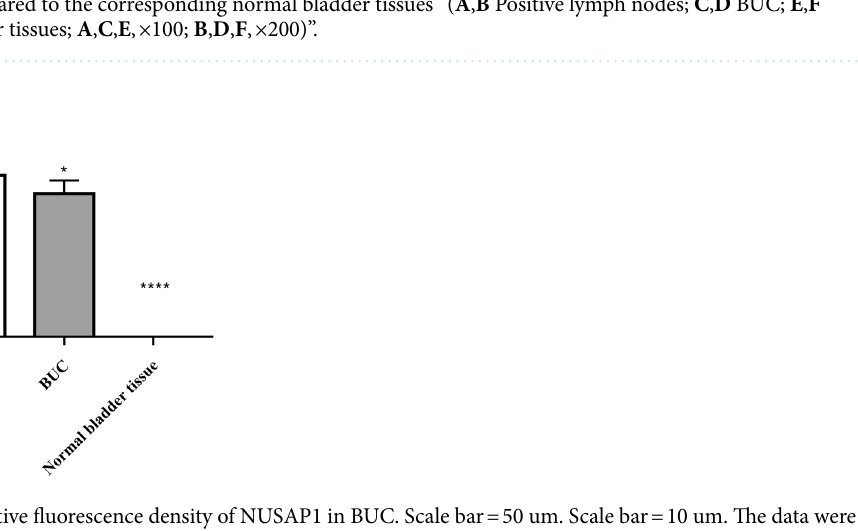
Figure 2. Relative fluorescence density of NUSAP1 in BUC. Scale bar = 50 um. Scale bar = 10 um. The data were analyzed by one-way ANOVA (* P > 0.05, BUC compared with the Positive lymph nodes *** P < 0.001 Normal bladder tissue compared with the BUC and Positive lymph nodes